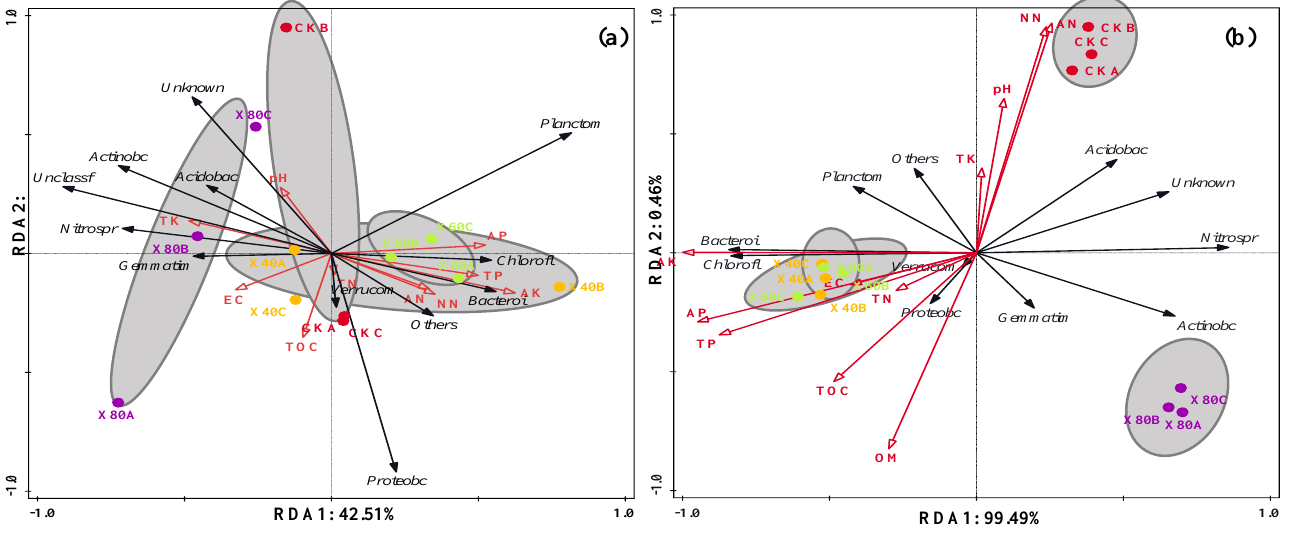
Figure 8. Ordination plots of the results from the redundancy analysis (RDA) to identify the relationships among the microbial (bacterial) taxa (black arrows) and the soil properties (red arrows) at the phylum level. ( a , b ): the relationship among the soil bacterial taxa and the soil properties at the level of 0 – 20 cm and 20 – 40 cm depth of soil, respectively; Bacterial taxa: Proteobacteria (Proteobc), Planctomycetota (Planctom), Bacteroidota (Bacteroi), Actinobacteriota (Actinobc), Gemmatimonadota (Gemmatim), Acidobacteriota (Acidobac), Verrucomicrobiota (Verrucom), Chloroflexi (Chlorofl), Nitrospirota (Nitrospir), and Unclassified. Soil properties: total nitrogen (TN), total phosphorus (TP), total potassium (TK), rapidly available phosphorus (AP), rapidly available potassium (AK), ammonium nitrogen (AN), nitrate nitrogen (NN), organic carbon (TOC), organic matter (OM), electrical conductivity (EC), and pH.